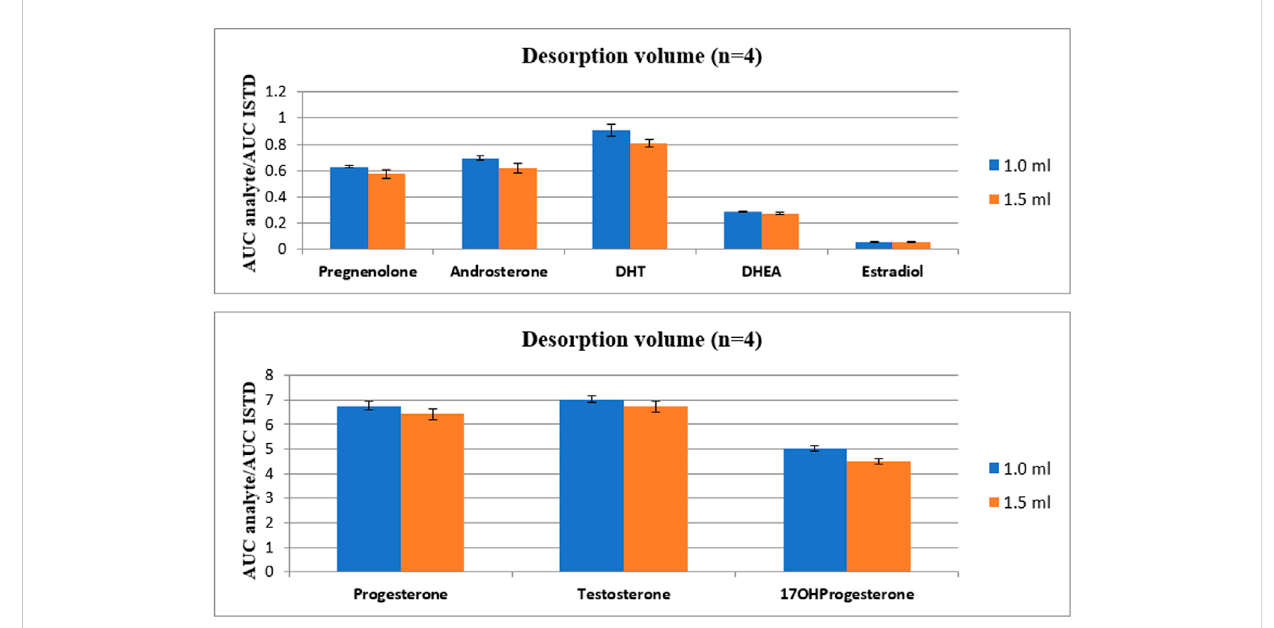
FIGURE 5 The comparison of the in fl uence of desorption volume on the intensity of steroid hormones.